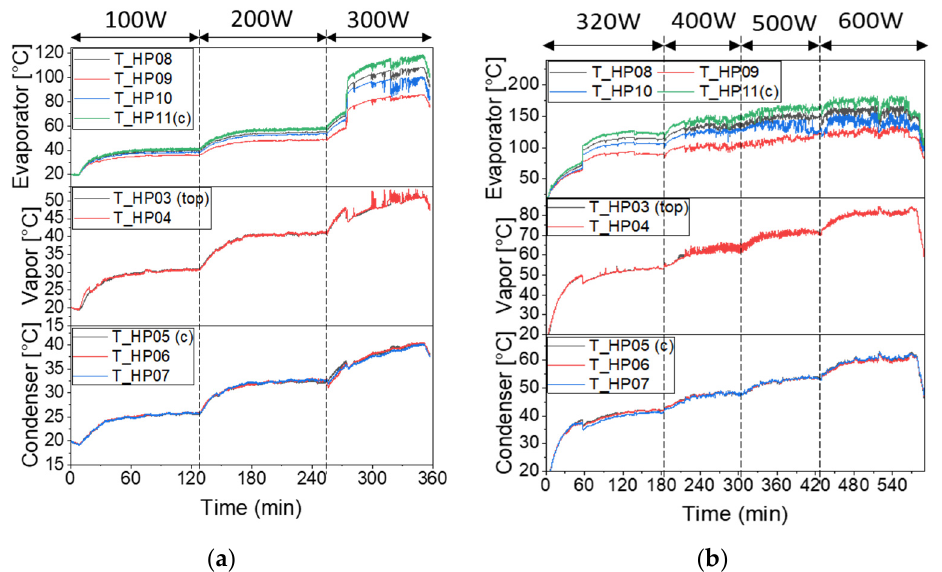
Figure 19. Mock-up-2’s temperature evolution with liquid inventory for 1 MW/m2 and electric copper heater calorimetric power: ( a ) 100, 200, and 300 W (heat flux: 0.2, 0.4, and 0.6 MW/m2); ( b ) 320, 400, 500, and 600 W (heat flux: 0.65, 0.8, 1.0, and 1.2 MW/m 2 .